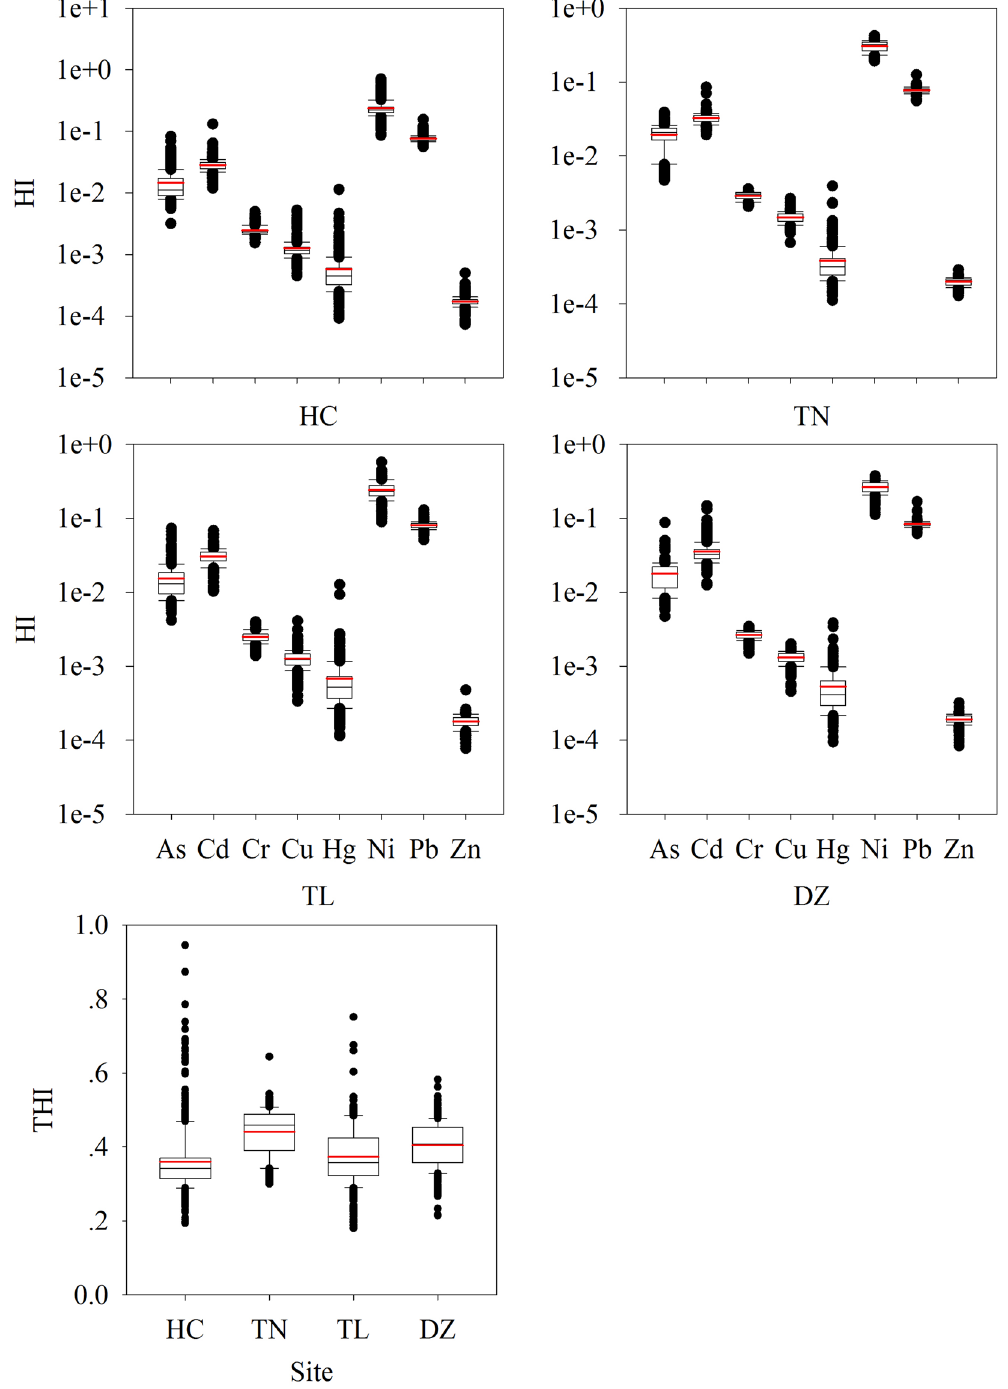
Figure 5. HI for adults exposure to HMs in soils of each County (THI for each County showed significant differences, p < 0.001 by Mann-Whitney U text) (symbols for boxplot are similar to Fig.